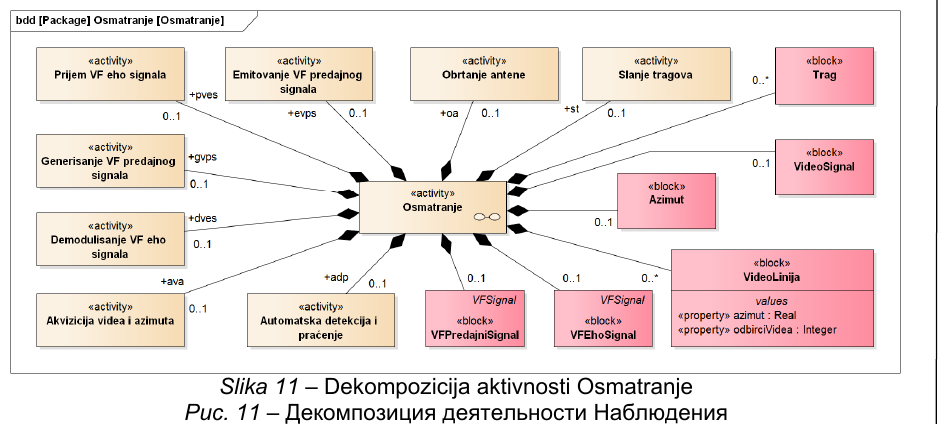
Figure 11 – Decomposition of the Osmatranje (surveillance)